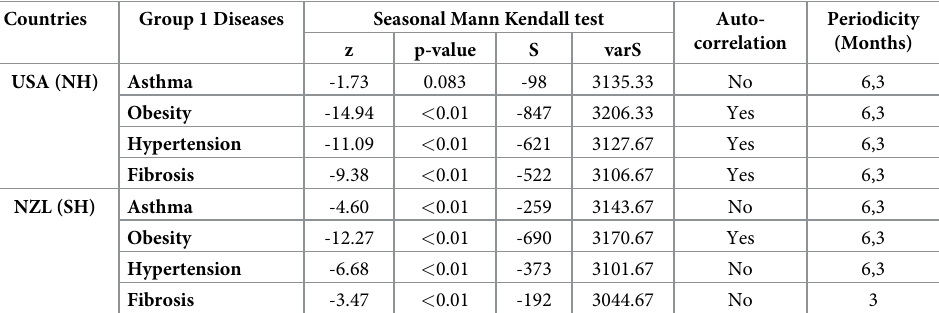
Table 3. The monthly RSV of GT time series seasonal analysis of USA (NH) and NZL (SH) for Group 1 diseases (Jan 2004 to Dec 2016) with obesity as the reference term. (Complete raw data is given in S3 Table).